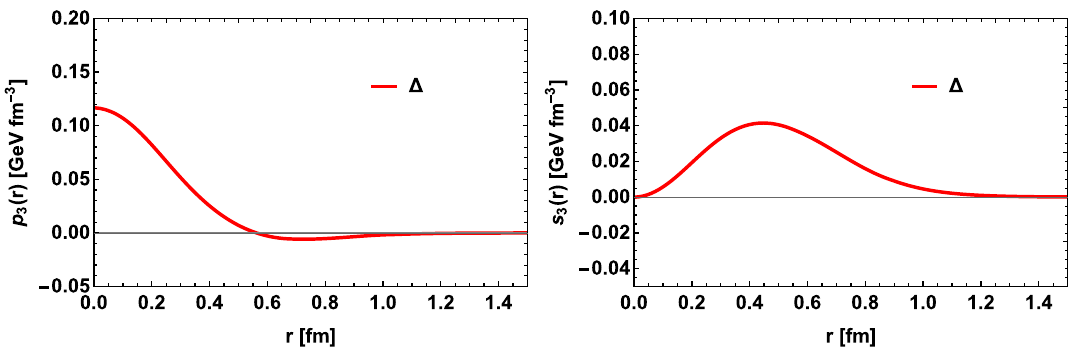
the nucleon, and the (cid:2) , respectively. Note that in the case of results of the NLO pressures they are reconstructed from Eq. (27) by using the approximated shear forces to comply with the von Laue condition